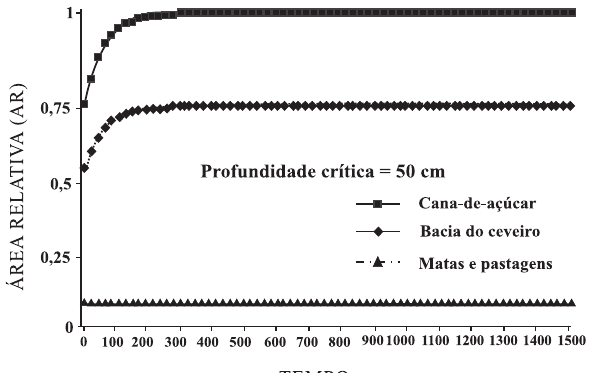
Figura 7. Gráfico do tempo de vida em anos nas áreas com cana-de-açúcar, com outros usos e na área de estudo como um todo, considerando a profundidade crítica de 100